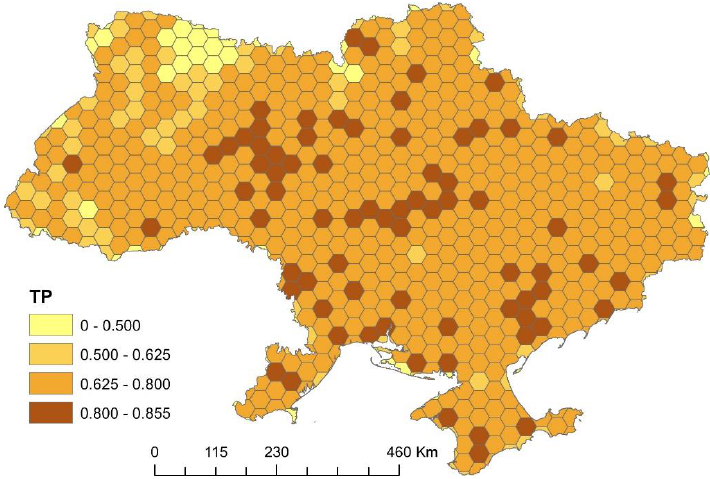
Figure 9. Ukraine road network transport provision level.